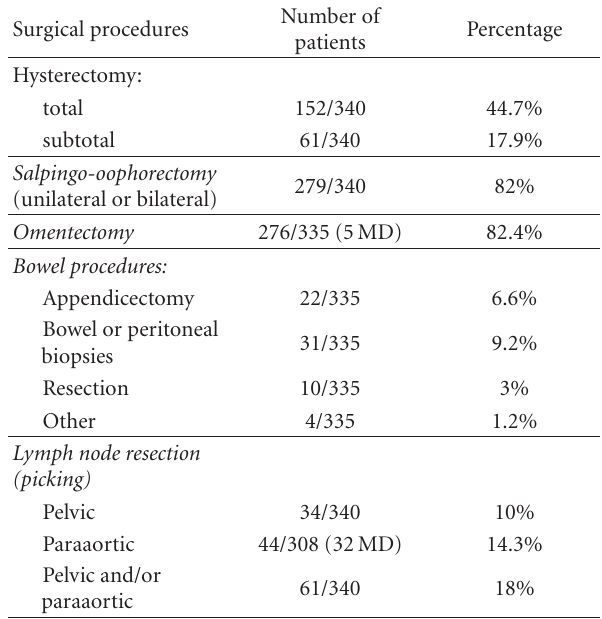
Table 1: Surgical procedures performed during primary cytoreduc- tive surgery.